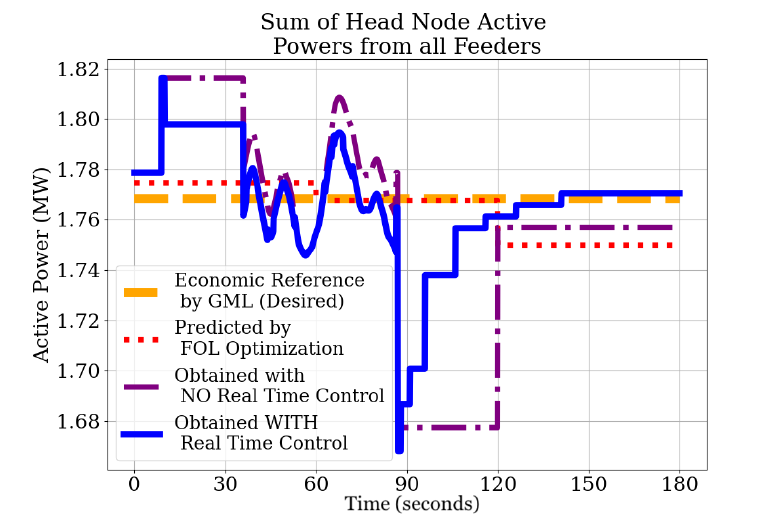
Figure 11. Simulation of intra- and inter-feeder controllers correcting static set-points to improve